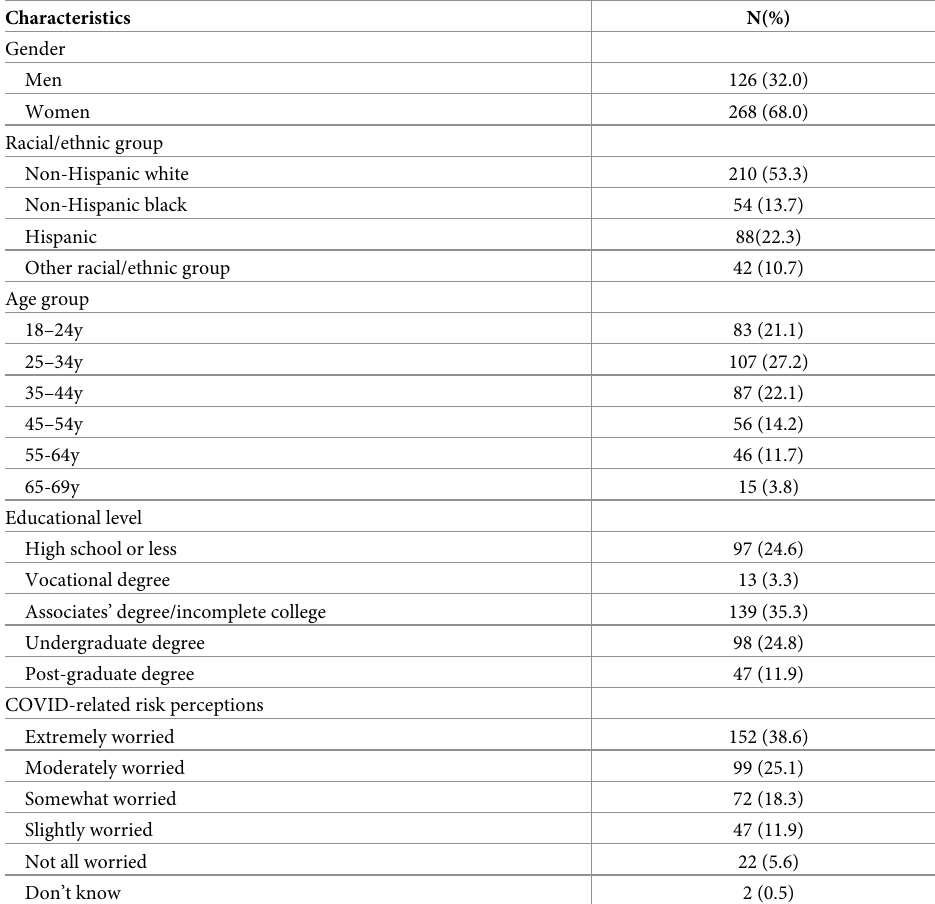
Table 2. Descriptive